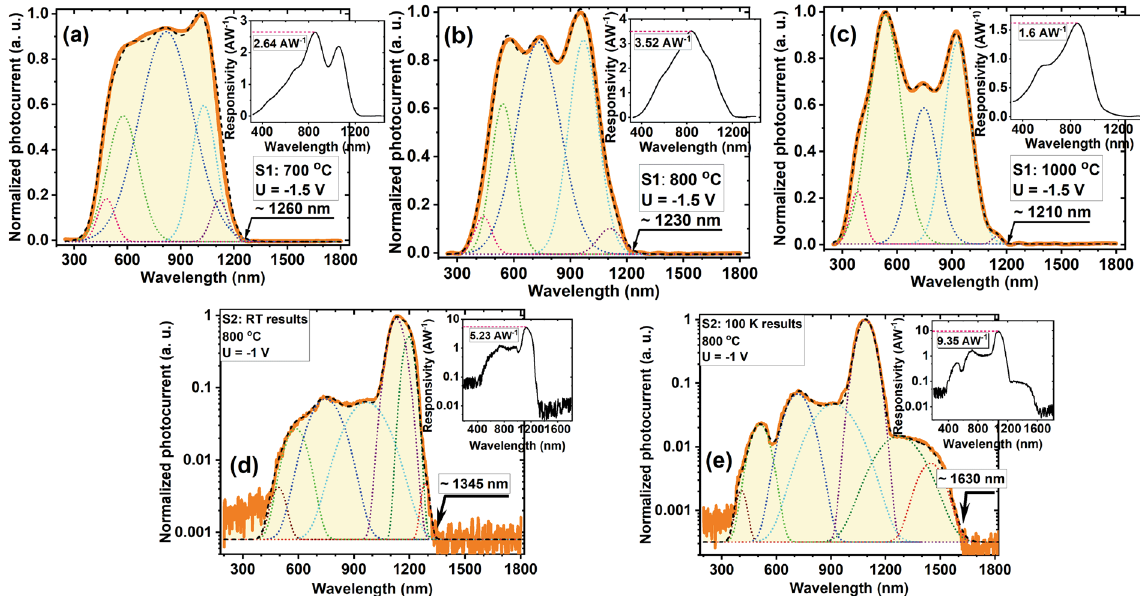
Figure 8. Normalized photocurrent spectra taken on S1 samples biased at − 1.5 V ( a ) 700 °C, ( b ) 800 °C and ( c ) 1000 °C RTA for 15 min. Also, photocurrent spectra taken on S2 samples annealed at 800 °C for 10 min and biased at − 1 V: ( d ) measured at room temperature (RT) and ( e ) at 100 K. The frequency of modulated light was 80 Hz. Each graphic contains as inset the corresponding spectral